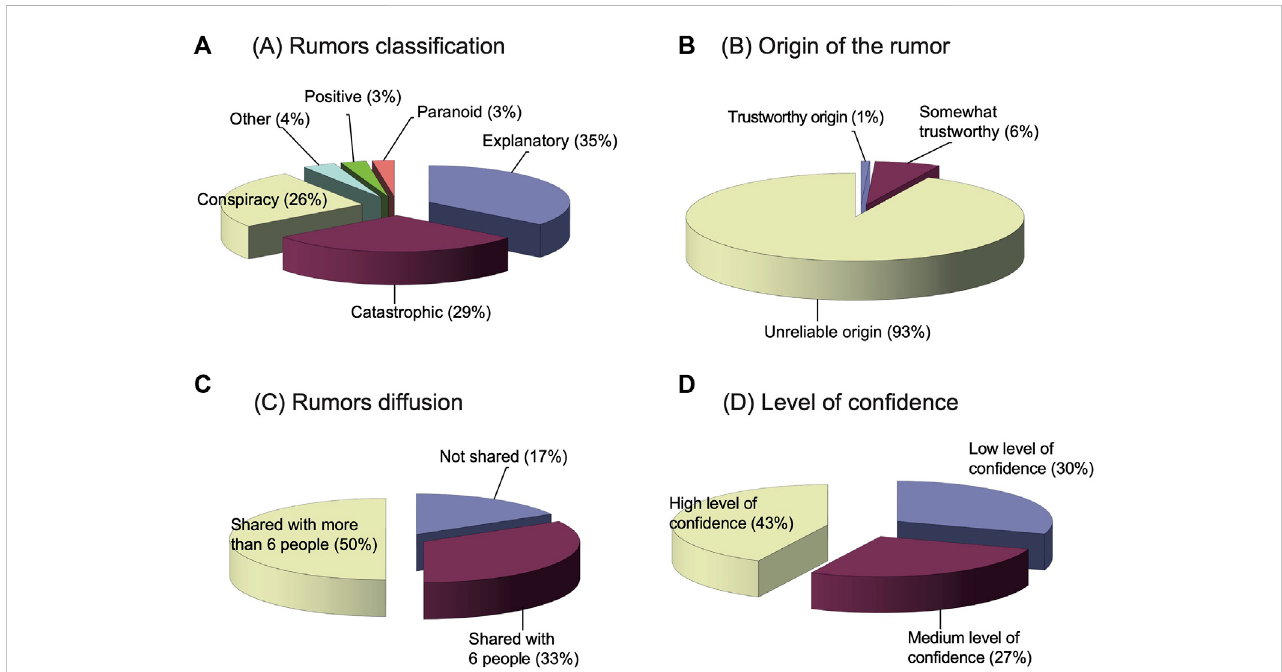
FIGURE 4 (A) Rumorsclassi fi cation.Collectedrumorswereclassi fi edindifferent categories based ontheircontent.The mostcommonare:explanatory(when the rumor focuses on the cause of the earthquake); catastrophic (when it suggests disruptive outcomes); conspiracy (when the emphasis is on alleged truth distortion by media or public institutions). (B) . Reliability of the rumor ’ s source. We considered the institutions (such as the national Civil Protection Department) as trustworthy sources, while individuals and social media are considered unreliable. According to this classi fi cation, most rumors originatedfromunreliablesources. (C)